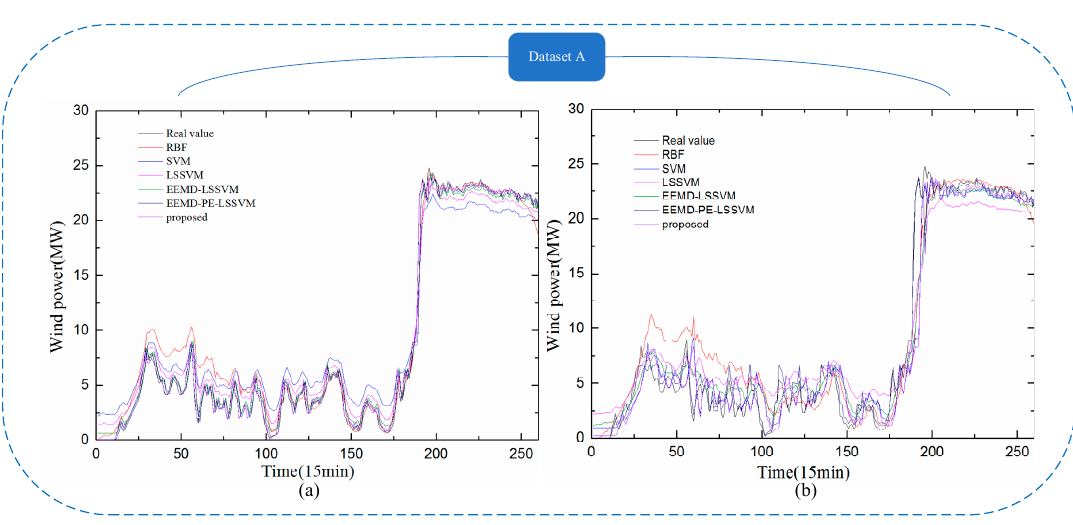
Figure 9. Comparison between the forecast and real values for Dataset A. ( a ) 1-step-ahead result; ( b ) 4-step-ahead result.